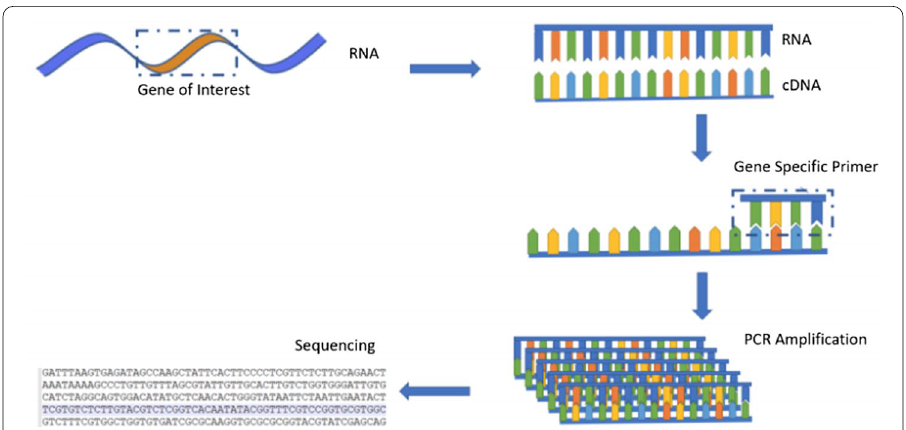
Fig. 13 Rough overview of RT-PCR amplifications (Image taken from Lopez-Rincon et al.